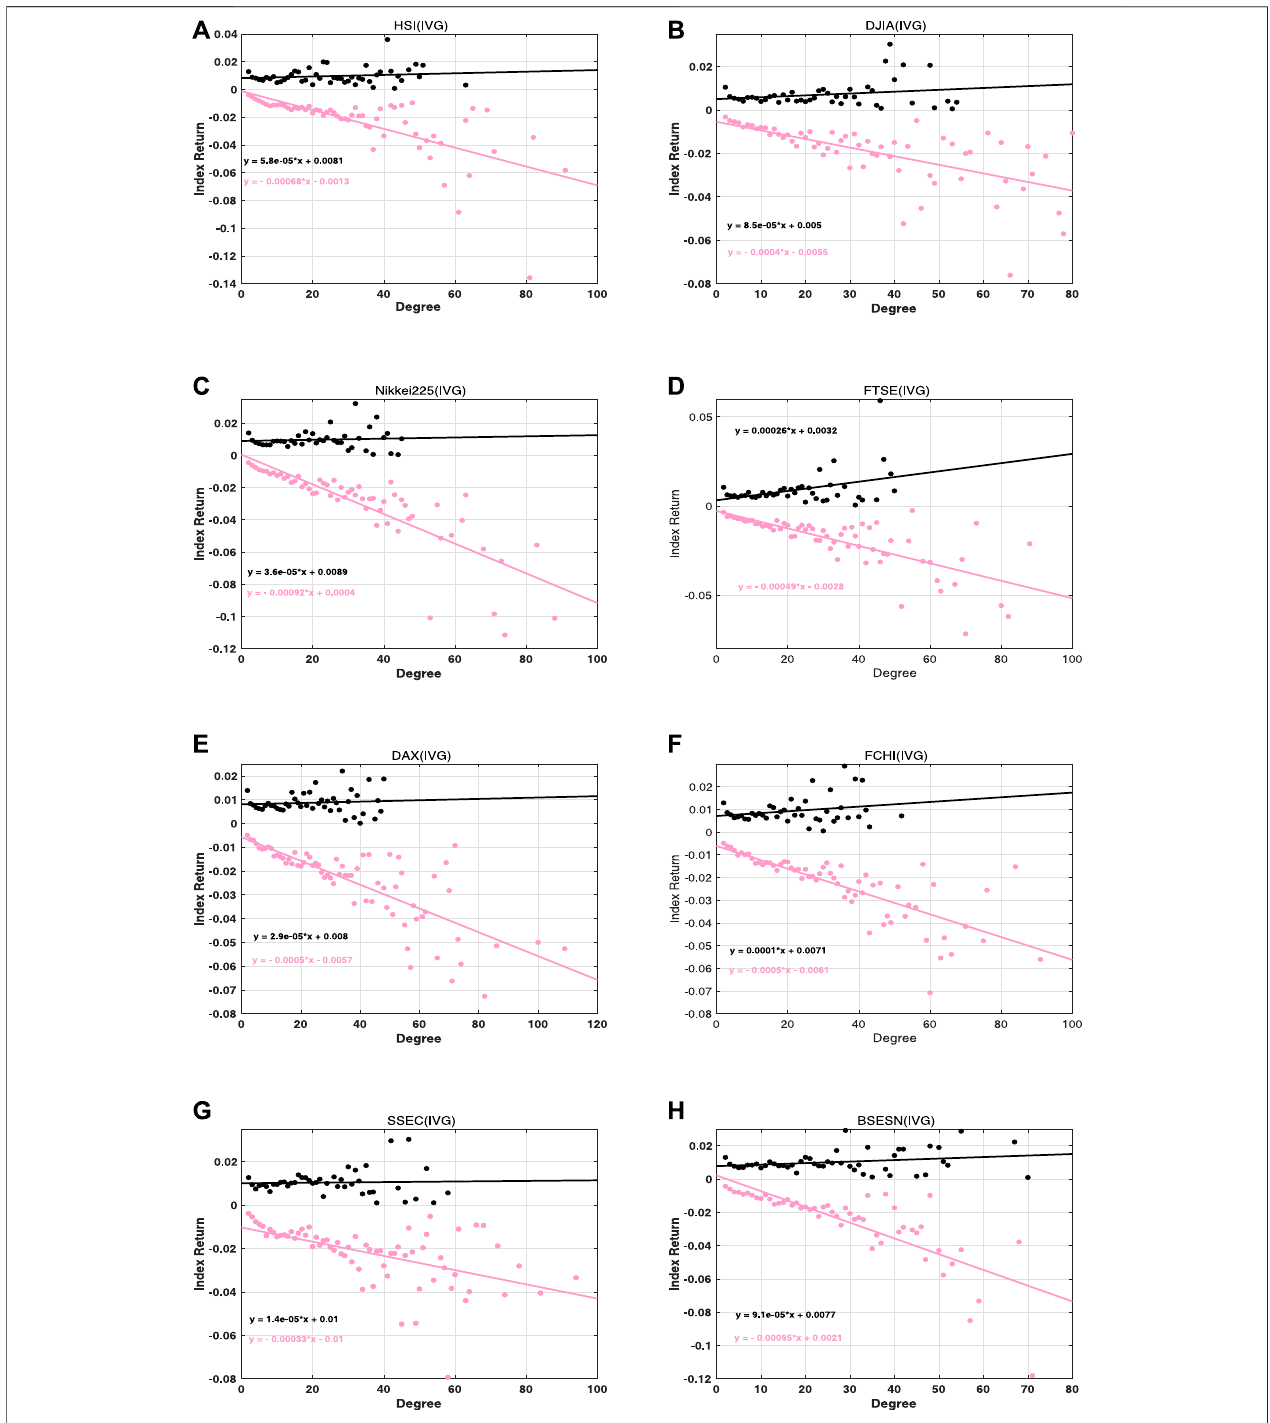
FIGURE 11 | Conditional expected index returns based on the degree of rise and fall price motions in IVG networks for the eight stock indices. Red indicates a rise and black indicates a fall. Figure 11 , the absolute fall slopes exceed the rise slopes for all of the stock indices. This implies that all of the markets crash at logarithmic rates. We also note that the FTSE and FCHI have